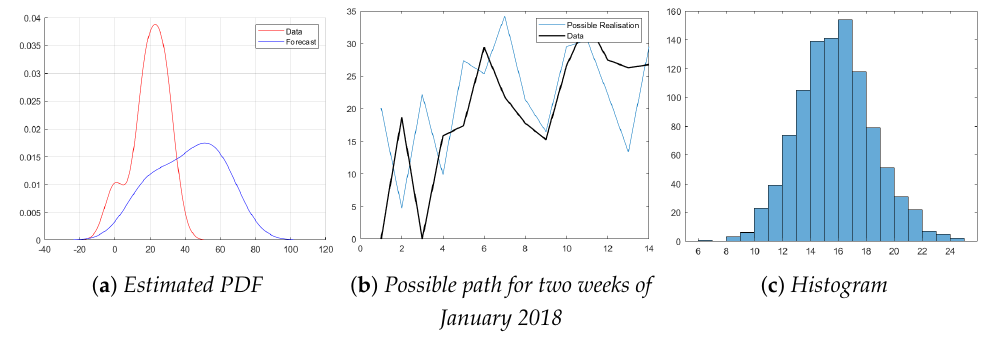
Figure 16. Summary of results for autumn/winter